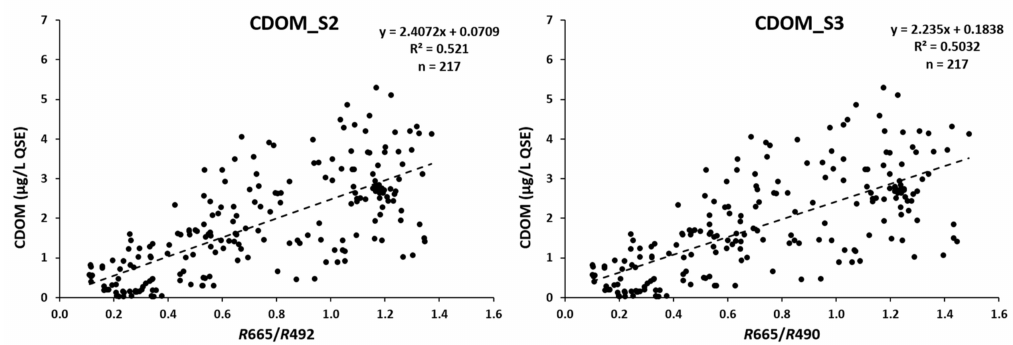
Figure 5. CDOM algorithms recalculated using all database.